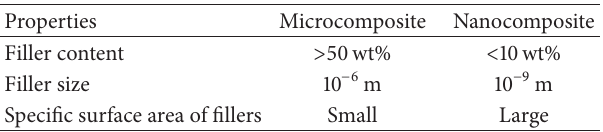
Table 1: Comparison between microcomposites and nanocompos-